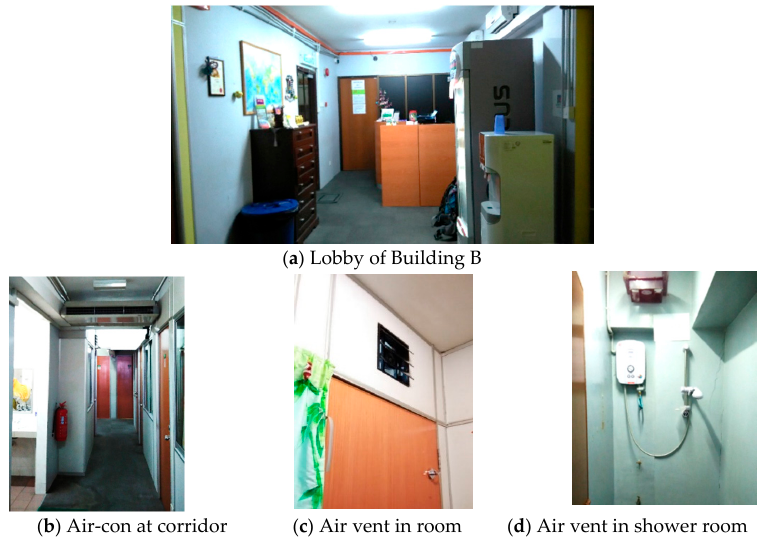
Figure 7. Building condition in Building B.